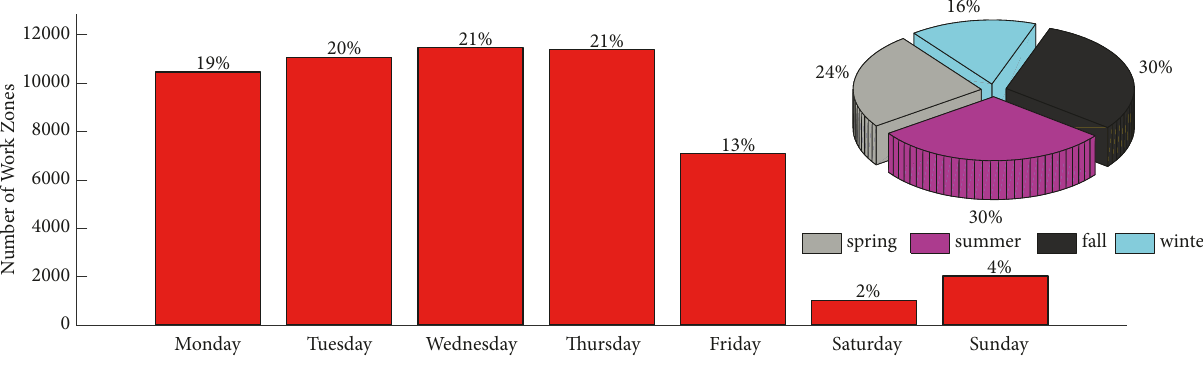
Figure 4: Most maintenance work was carried out on weekdays and during summer and fall.